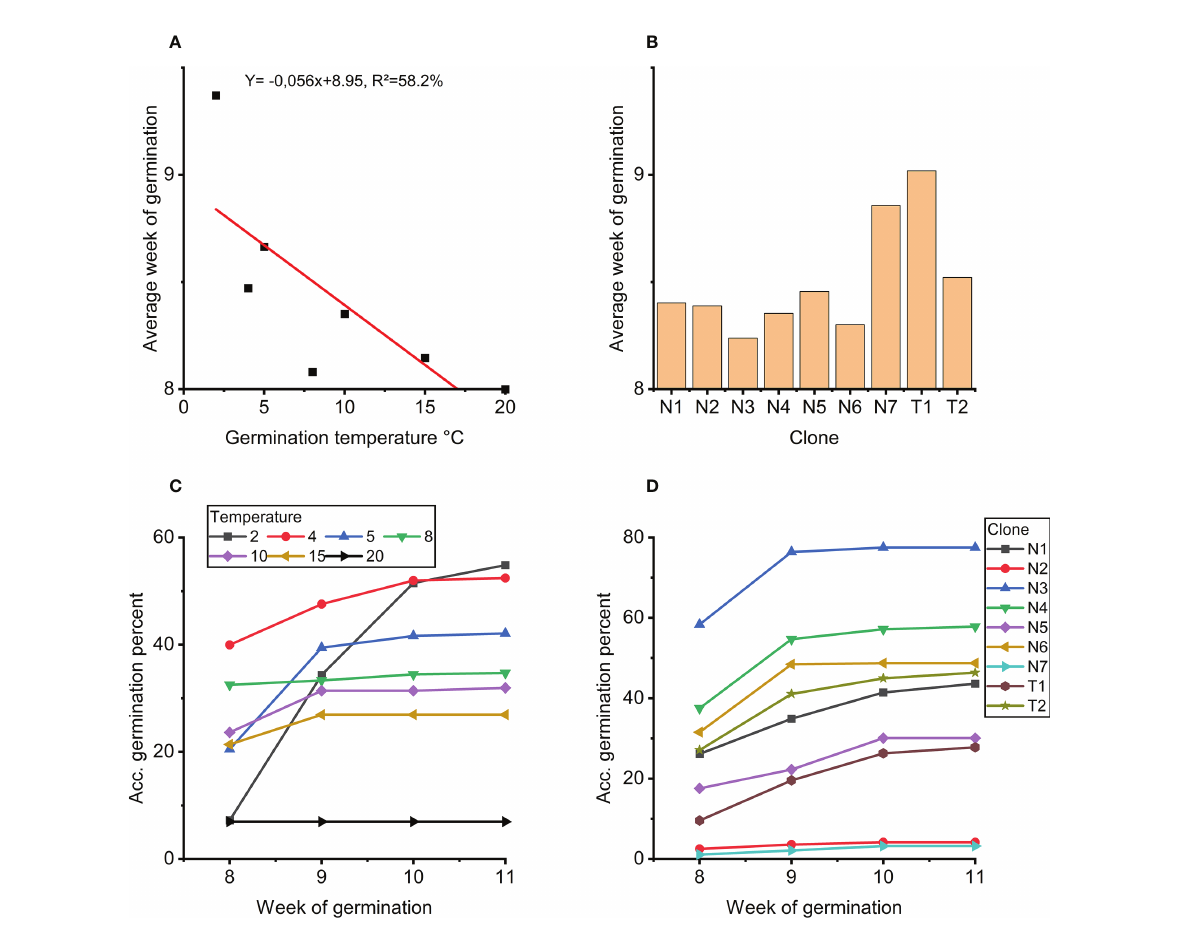
FIGURE 4 (A) Average week of germination as a function of germination temperature. (B) Average week of germination for each clone. (C) Accumulated germination in percentage for weeks 8 to 11 for each temperature treatment 2-20°C. (D) Accumulated germination in percentage for weeks 8 to 11 for each